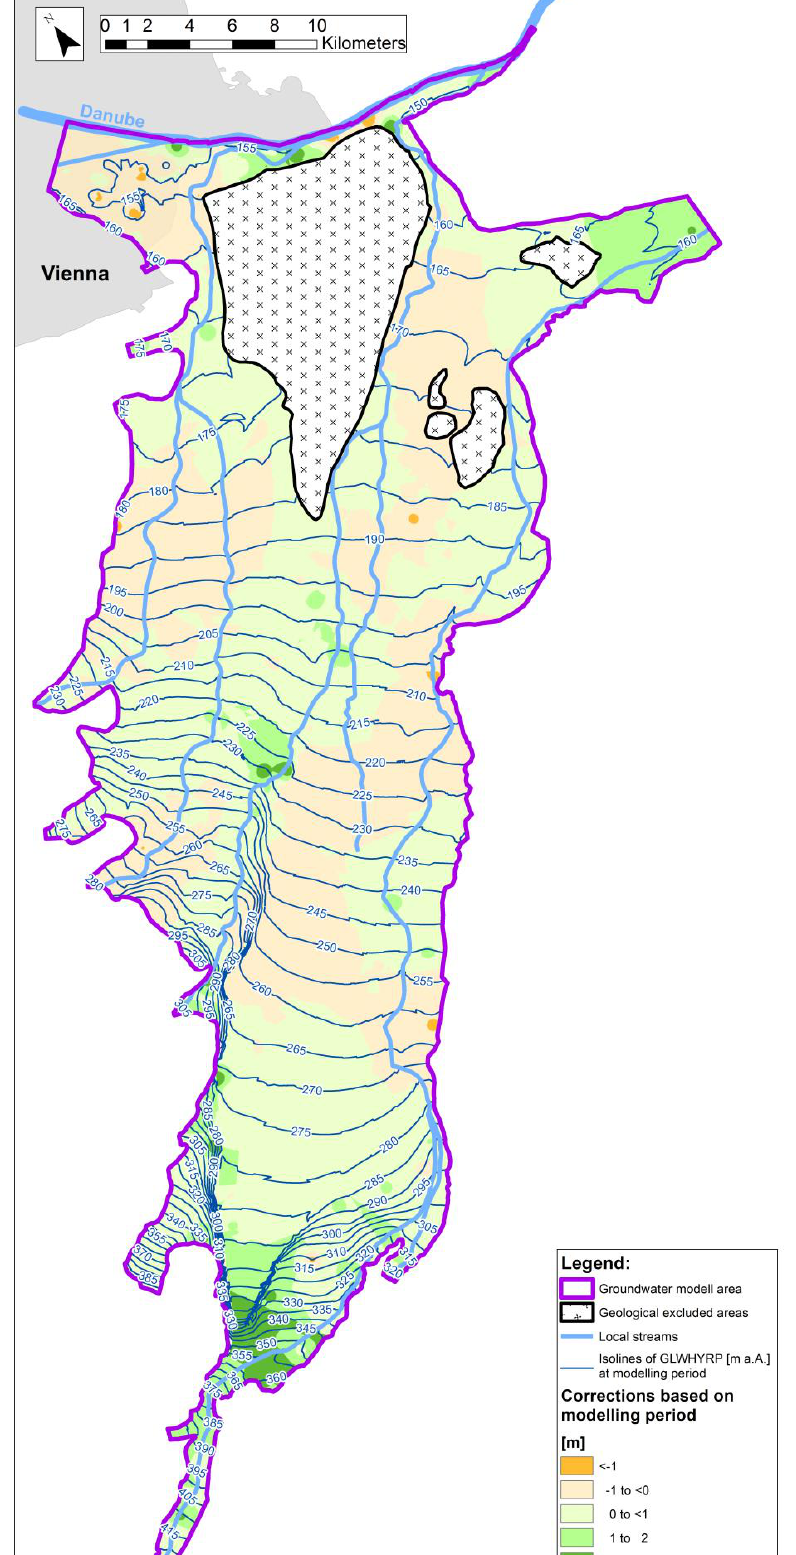
2 Figure 4. Distribution of GLsWHYRP based on modelled groundwater levels corrected by interpolated discrepancies during modelling period at observation wells; colored areas show resulting